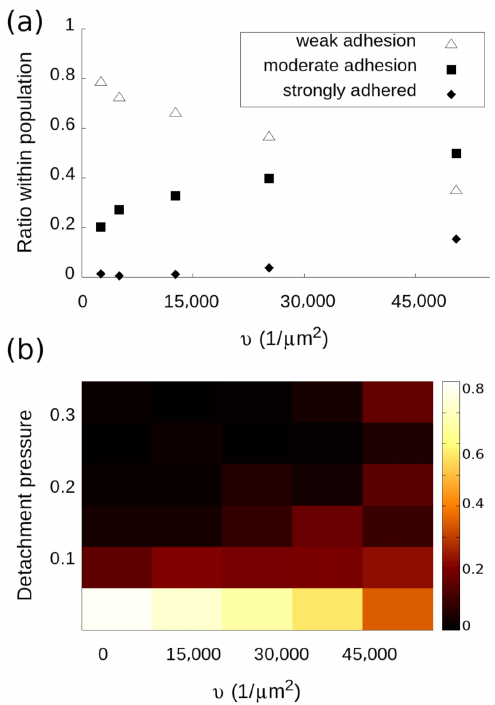
Figure 4. Subpopulation analysis of HeLa cells on different RGD densities. ( a ) Dependence of the fraction of weakly, moderately, and strongly adhered cells on the RGD density. Weak adhesion stands for cells that were picked up in the first round of probing by the negative pressure of 0.07 atm, while strongly adhered cells were not picked up even with a negative pressure of 0.22 atm. Moderate adhesion stands for cells in between the 0.07–0.22 atm range. ( b ) Heat map of the distribution of cell adhesion. The color scale indicates the ratio of cells having the indicated detachment pressure on the substrate with the given RGD density. It can be observed that the distribution widens and flattens with increasing ligand